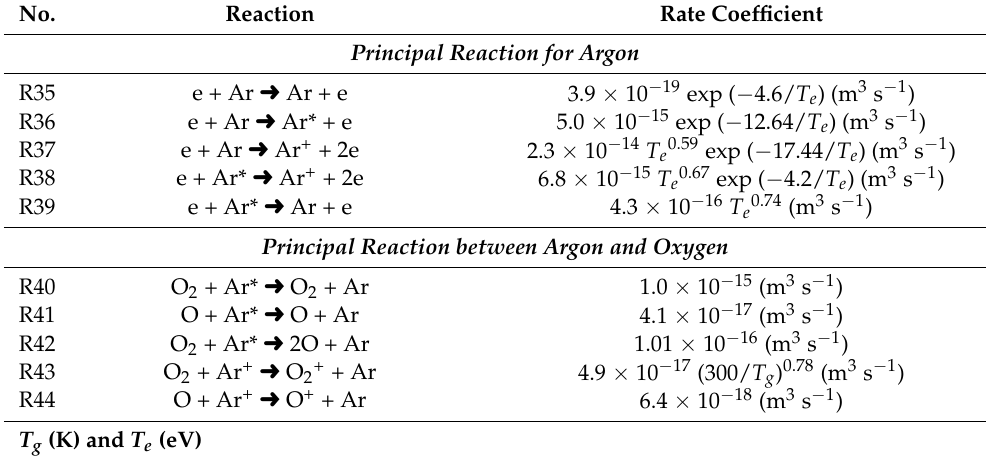
Table 3. List of reactions for Argon in Ar/O 2 mixture.